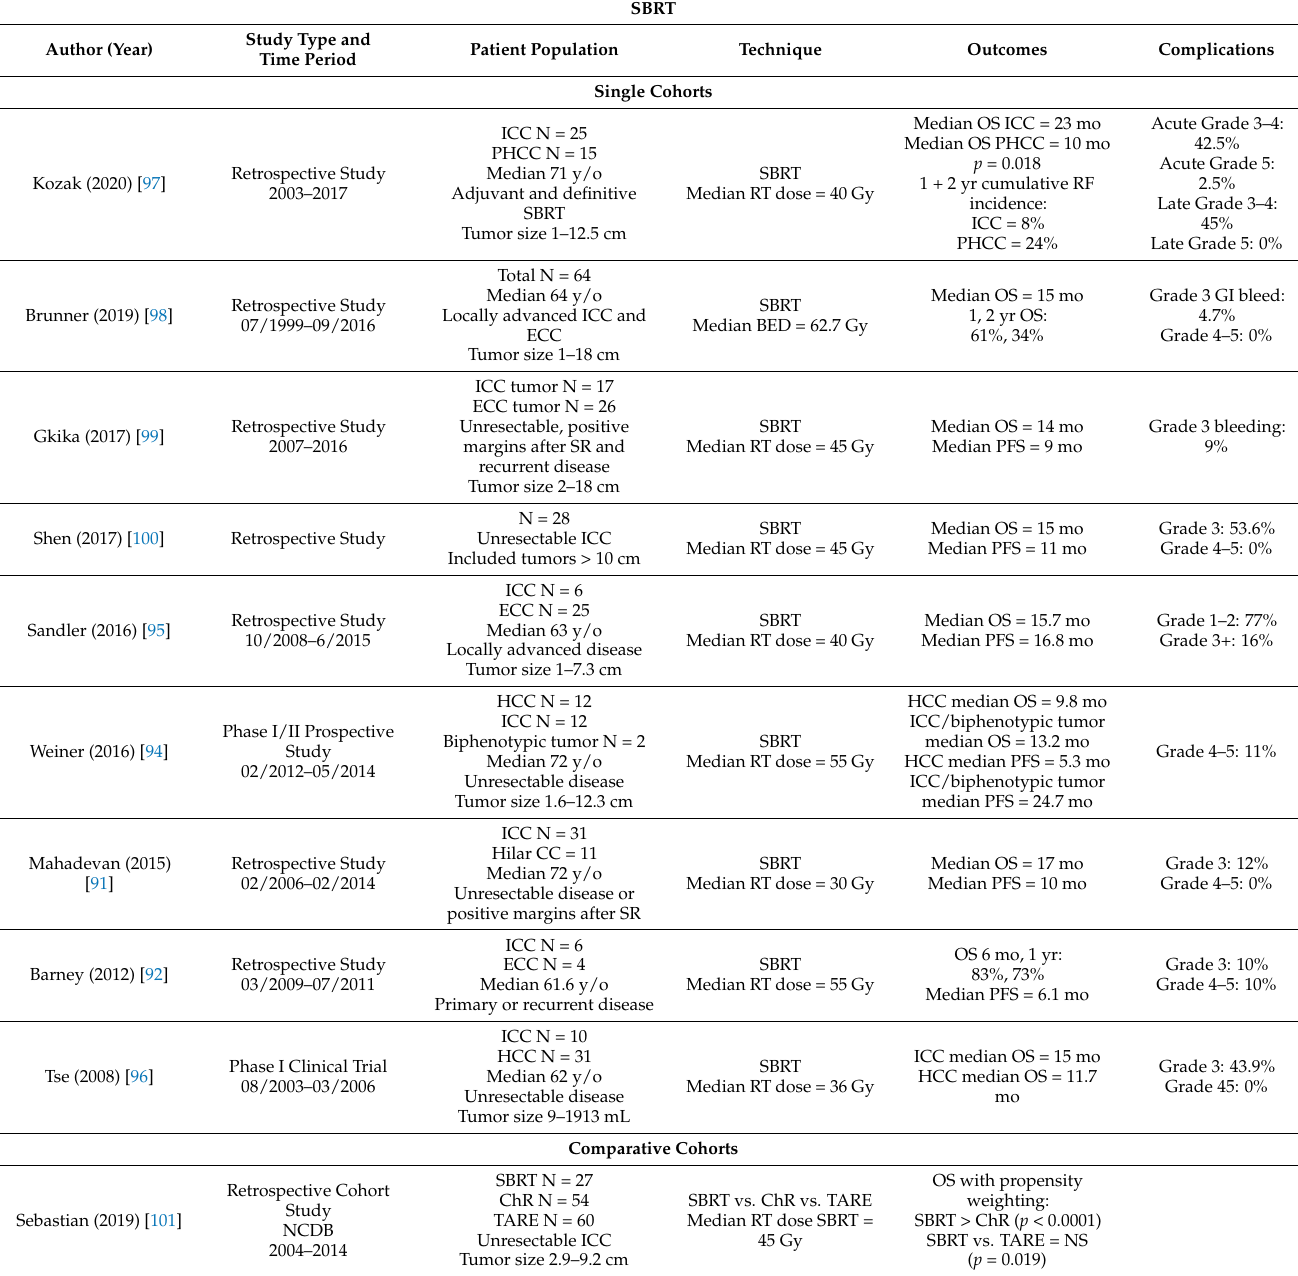
Table 6. Studies examining stereotactic body radiotherapy (SBRT) for intrahepatic cholangiocarcinoma.